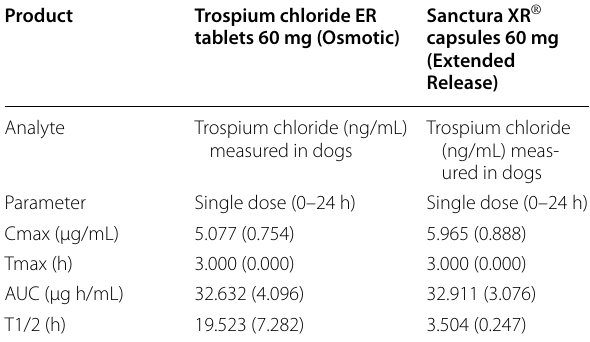
Table 12 Pharmacokinetic parameters summary of trospium chloride osmotic tablets vs Sanctura XR ® capsules